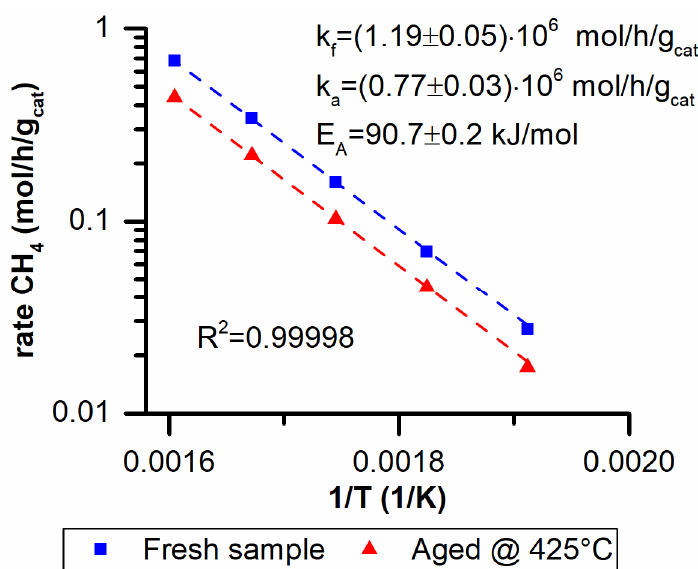
Figure 6. Activation energy ( E A ) and preexponential factor for a fresh ( k f ) and aged ( k a ) sample at 425 °C.